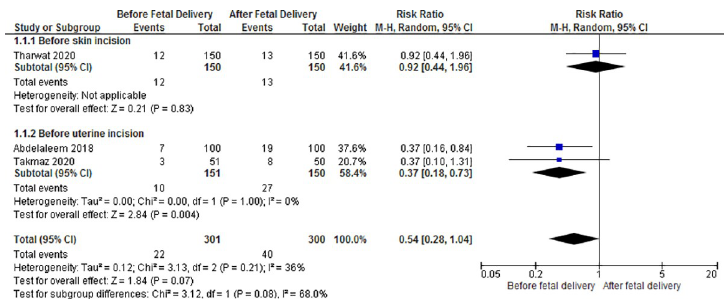
Fig 3. Forest plot of oxytocin given before versus after fetal delivery. Outcome: need for additional uterotonic.